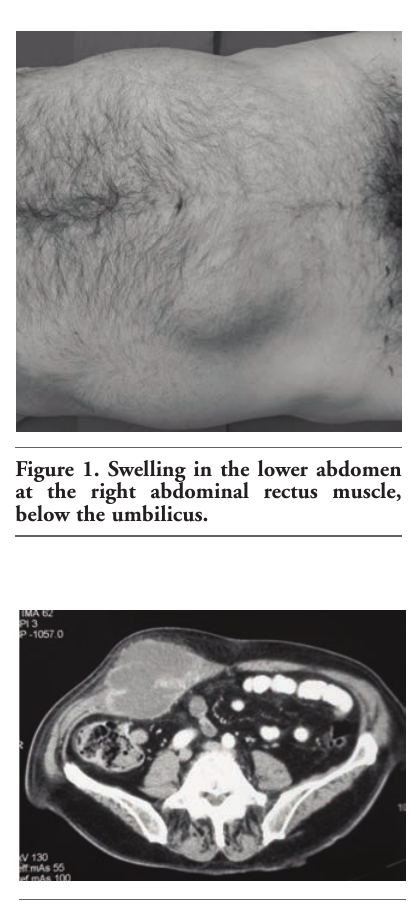
Figure 2. Abdominal computed tomogra- phy: abscess with diaphragms, inside the right abdominal rectus muscle below the